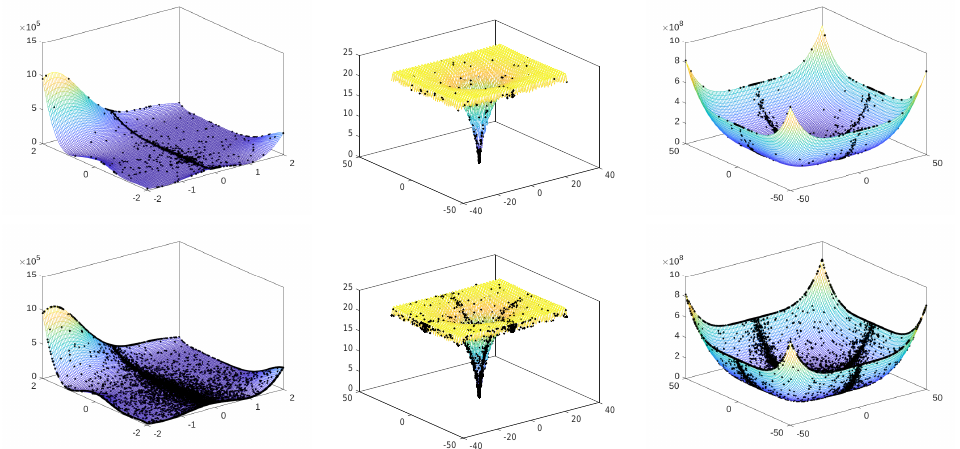
Figure 7. Obtained solutions in the search space of functions f 21 , f 24 , and f 25 ; by the ESCA algorithm ( first row ); and the SCA algorithm ( second row